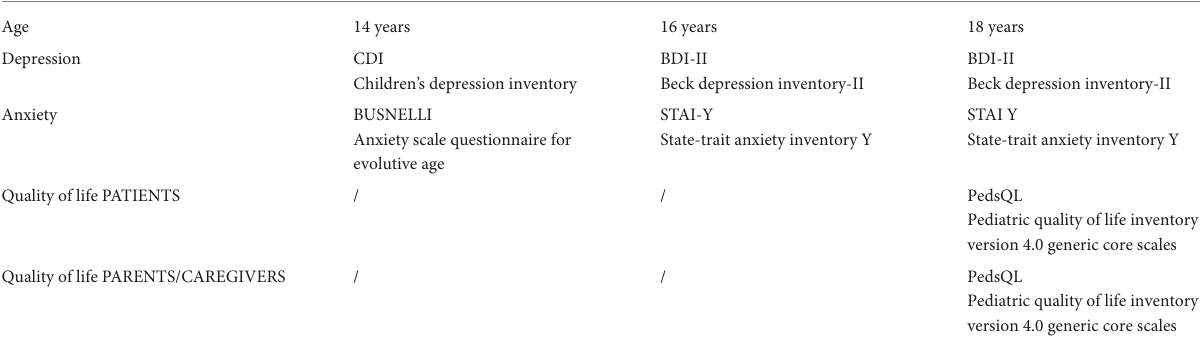
TABLE 2 Psychometric tests administered during the transition process from pediatric to adult